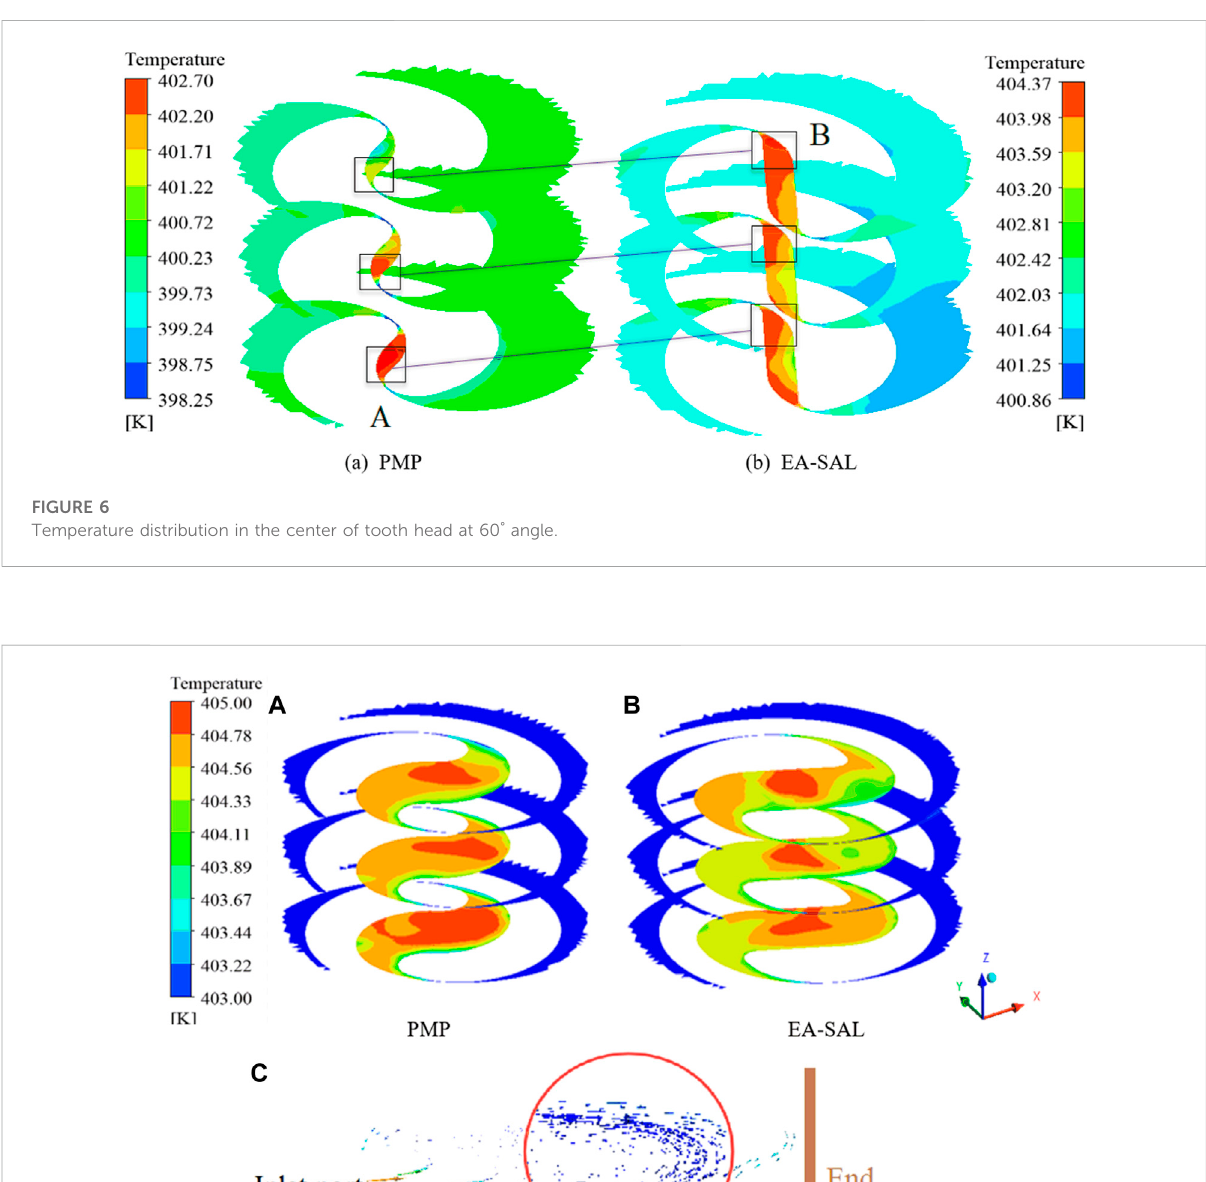
reason is that the working fl uid fl ows more smoothly towards the left side along the inner wall of the fi xed scroll under the action of kinetic energy after entering the central suction chamber. On the contrary, the working fl uid